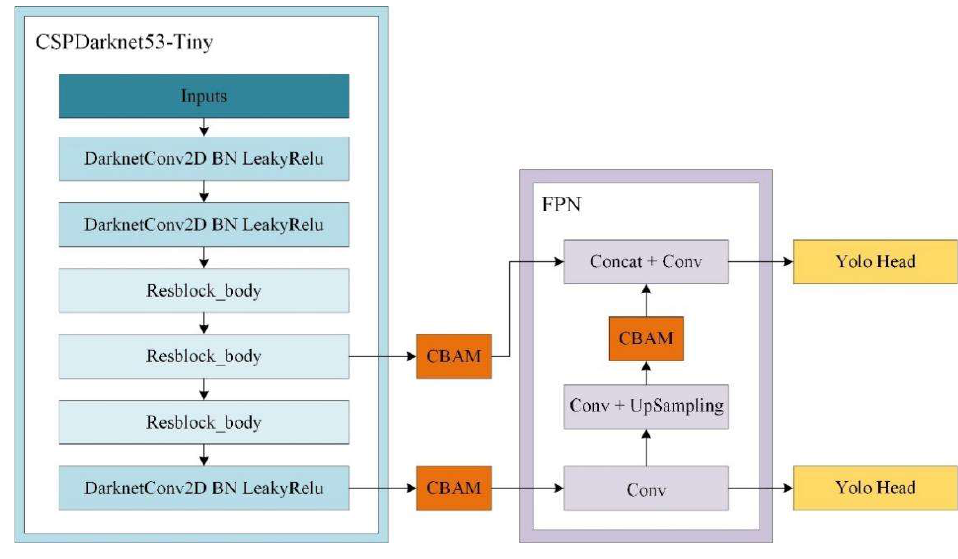
Figure 4. Enhanced feature extraction network with CBAM.